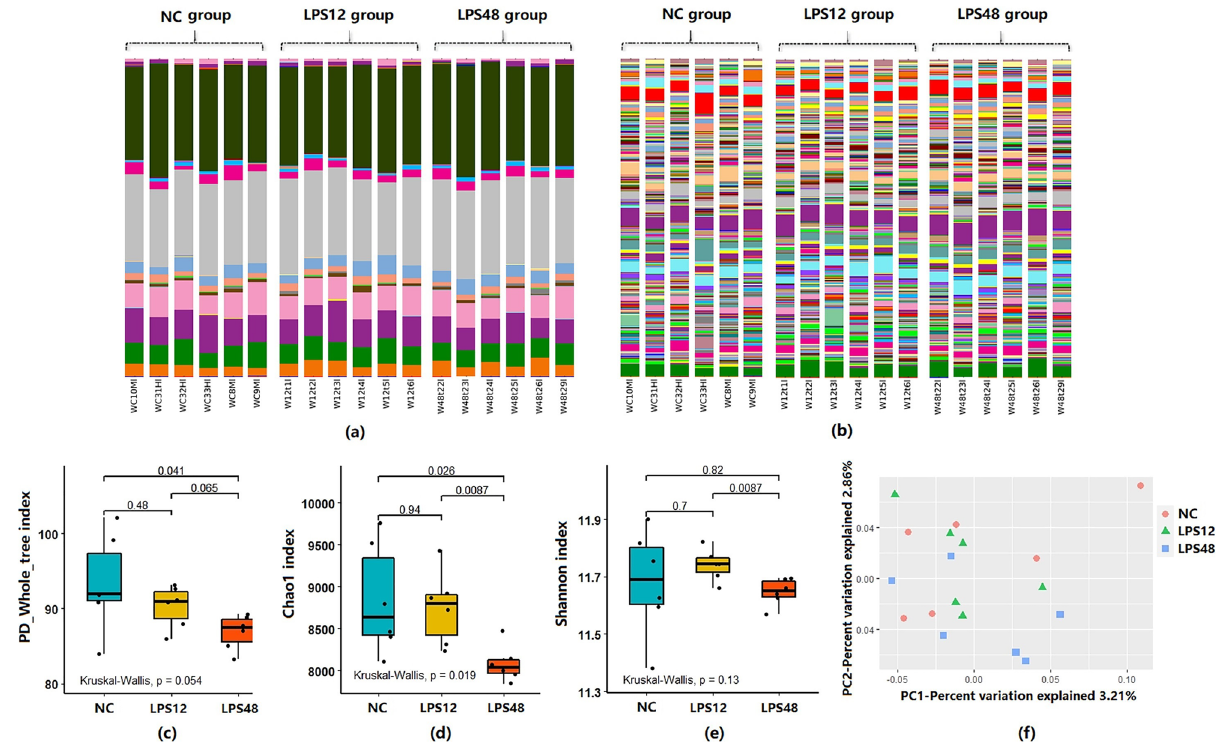
Figure 4. Overall assessment of the microbiota in lung tissue. Bar plots of the lung microbiota components in each sample in each of the three groups. Annotated at ( a ) phylum level; ( b ) genus level. In our comparison of α-diversity values of the lung microbial communities among the three groups, the ( c ) PD whole tree, ( d ) Chao1, and ( e ) Shannon α-diversity indices of all narrowed after LPS injection and decreased significantly in the LPS48 group. ( f ) Two-dimensional PCoA plots showing differences in the lung microbiota of rats from the three groups based on the Bray–Curtis distance metric. P = 0.002 and r 2 = 0.1263 in the Adonis test; P = 0.002 and adjusted r 2 = 0.1258 in